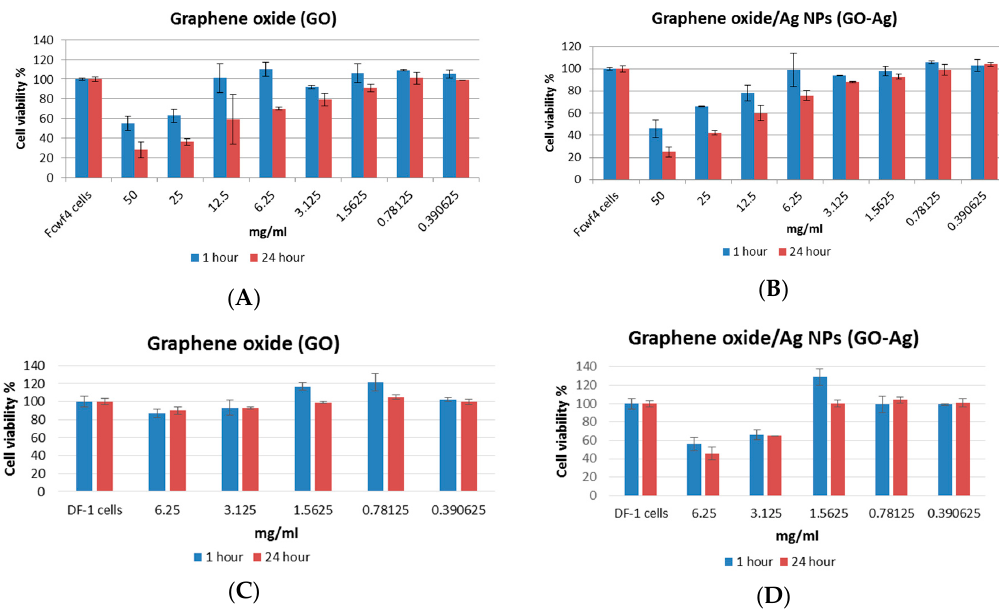
Figure 5. Viability of cells in the presence of graphene oxide (GO) and GO with silver nanoparticles (GO-Ag). ( A ) GO in fcwf-4 cells; ( B ) GO-Ag in fcwf-4 cells; ( C ) GO in DF-1 cells; ( D ) GO-Ag in DF-1 cells.